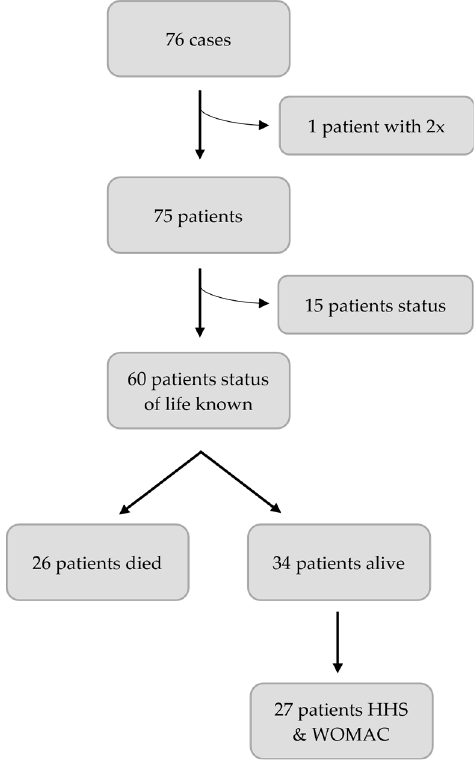
Figure 1. Flowchart study design.